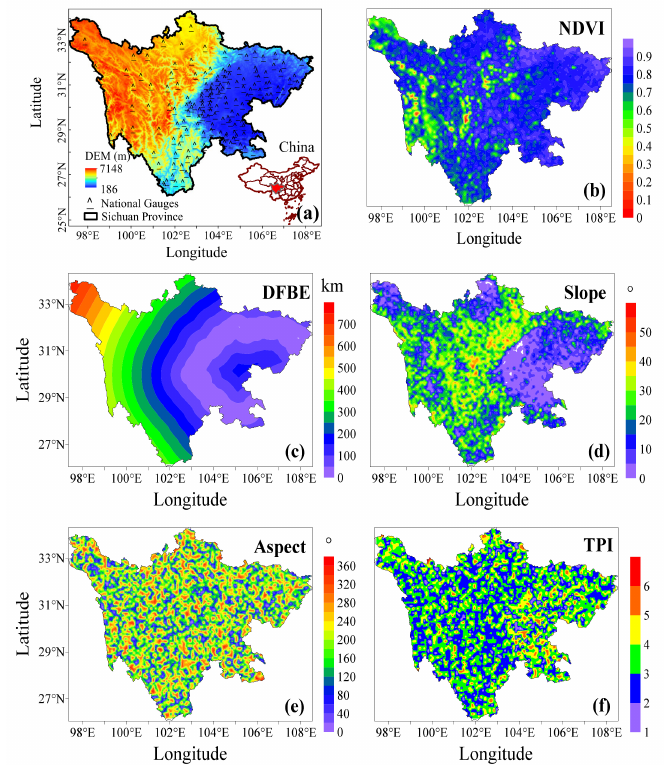
Figure 1. ( a ) Geographical location and digital elevation model (DEM) of the study area, and the spatial distributions of national gauges stations (black pentagrams); ( b – f ) represent the distributions of NDVI, DFBE, slope, aspect, and TPI over Sichuan Province,